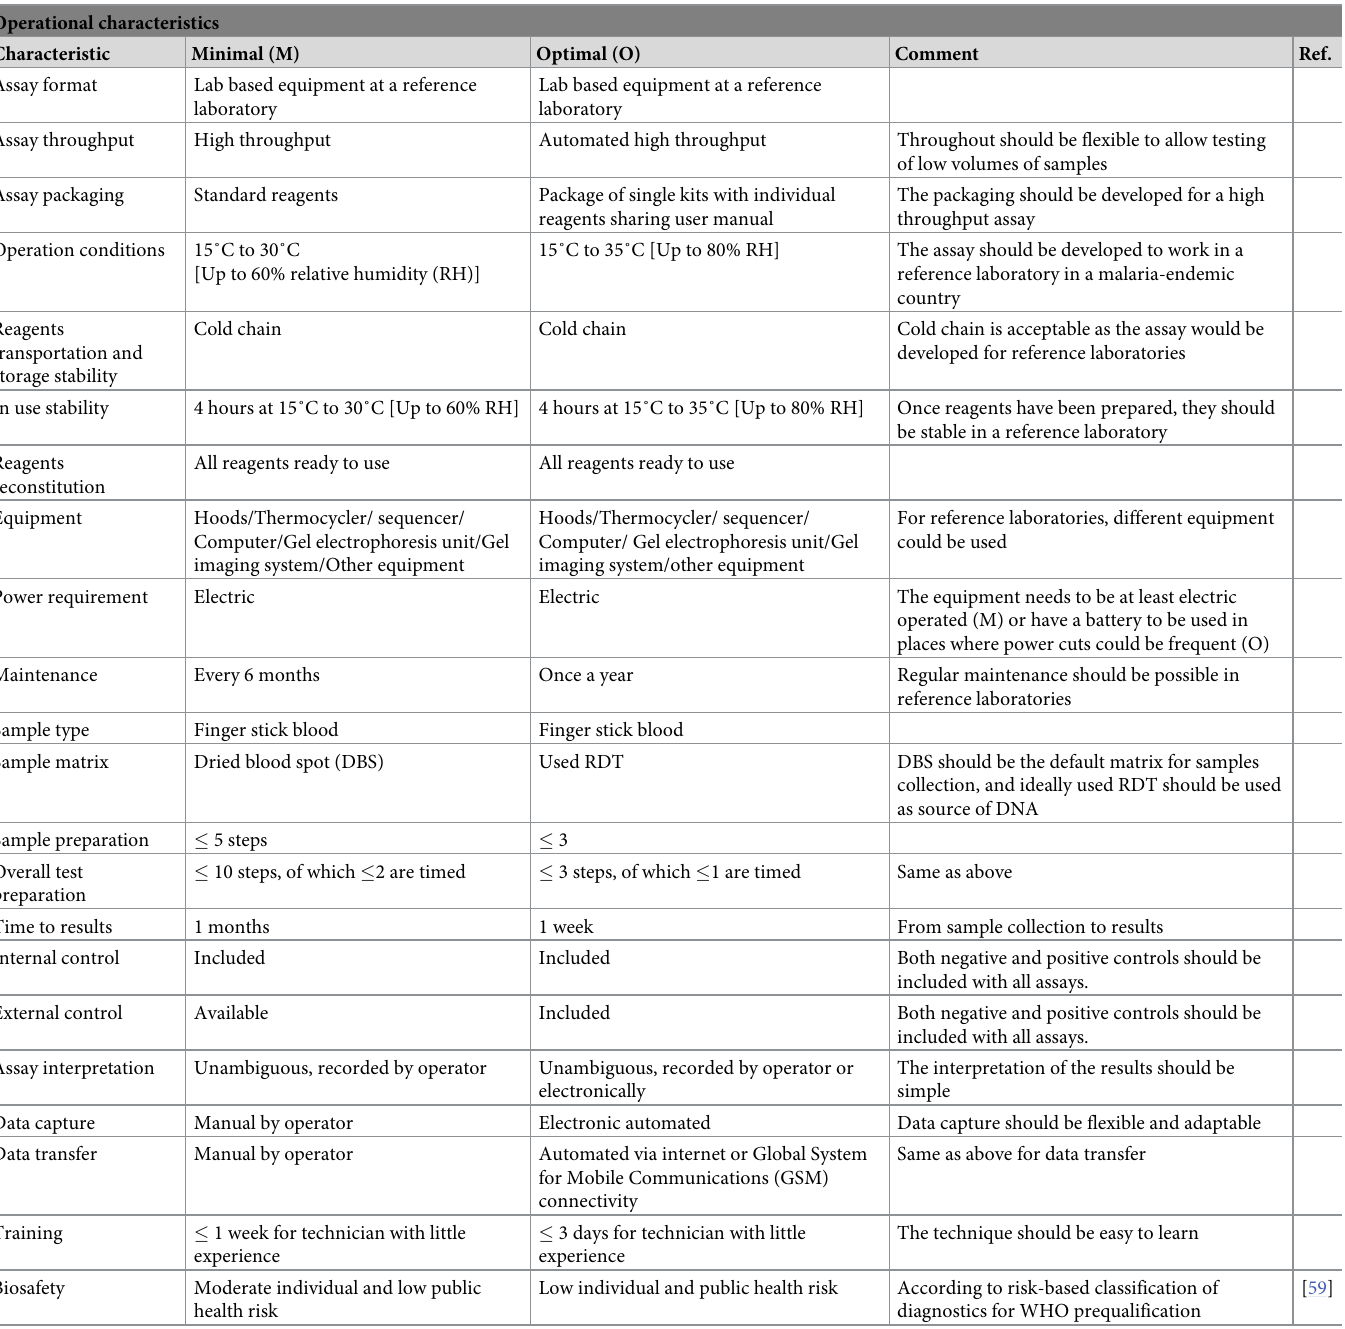
Table 4. Operational characteristics based on the consensus by the meeting of